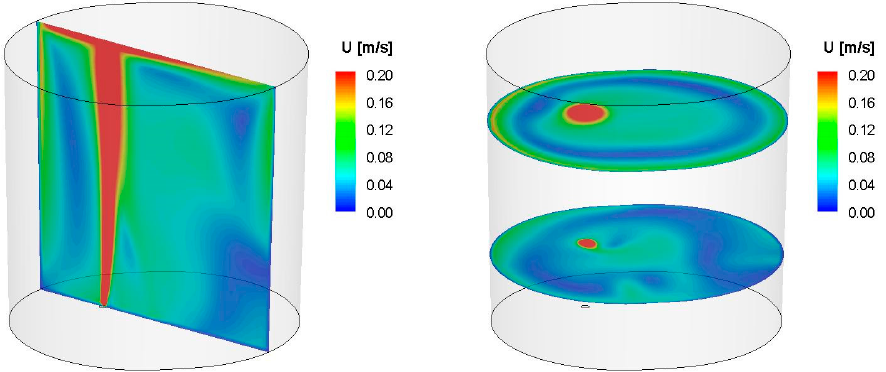
Figure 6. Contour maps of liquid steel velocity in selected control planes for simulation Sim_4 (density = 7004 kg m 3 , Ar flow = 50 L/min)